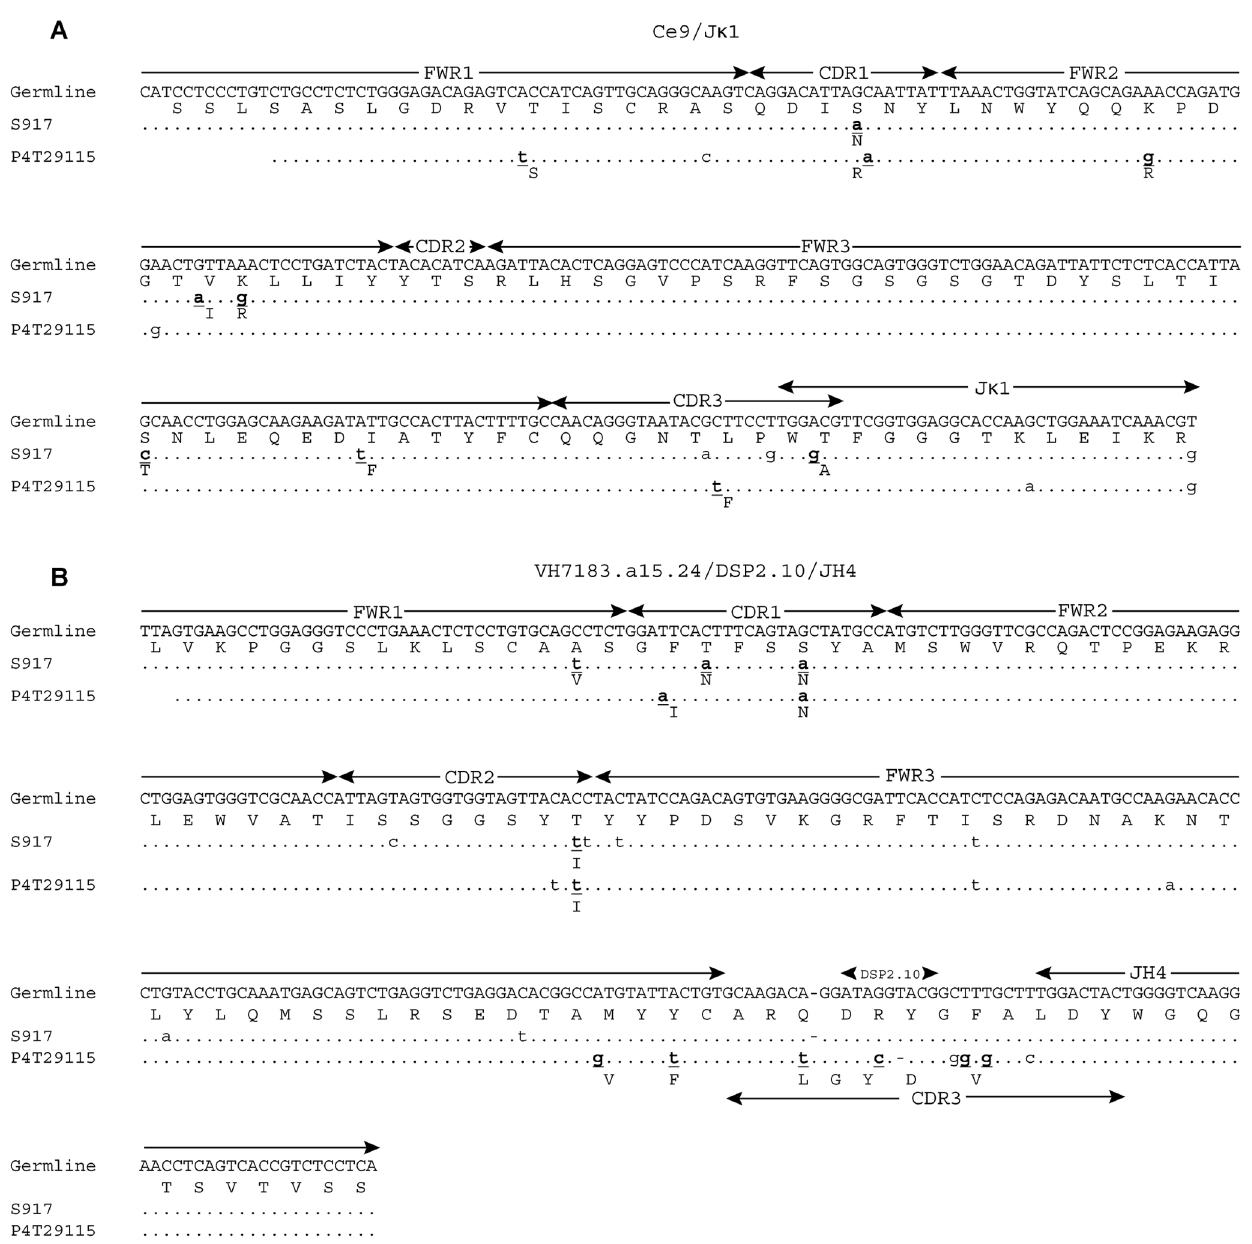
Figure 3. Sequence alignments of V L (A) and V H (B) genes from recurrent pairs between the hybridoma P4T29115 and phage display isolate S917. Replacement mutations are shown in bold font and the replaced amino acid residues are shown below each mutation. The ce9/J k 1germline sequence was obtained by manually juxtaposing the available germline ce9 (GenBank: AJ239197.1) and J k 1 (GenBank:V00777.1) sequences. The VH7183.a15.24/DSP2.5/JH4 germline sequence was obtained by manually juxtaposing the available germline VH7183.a15.24 sequence (GenBank:AJ851868.3) with the DSP2.5/JH4 sequence derived from S917.